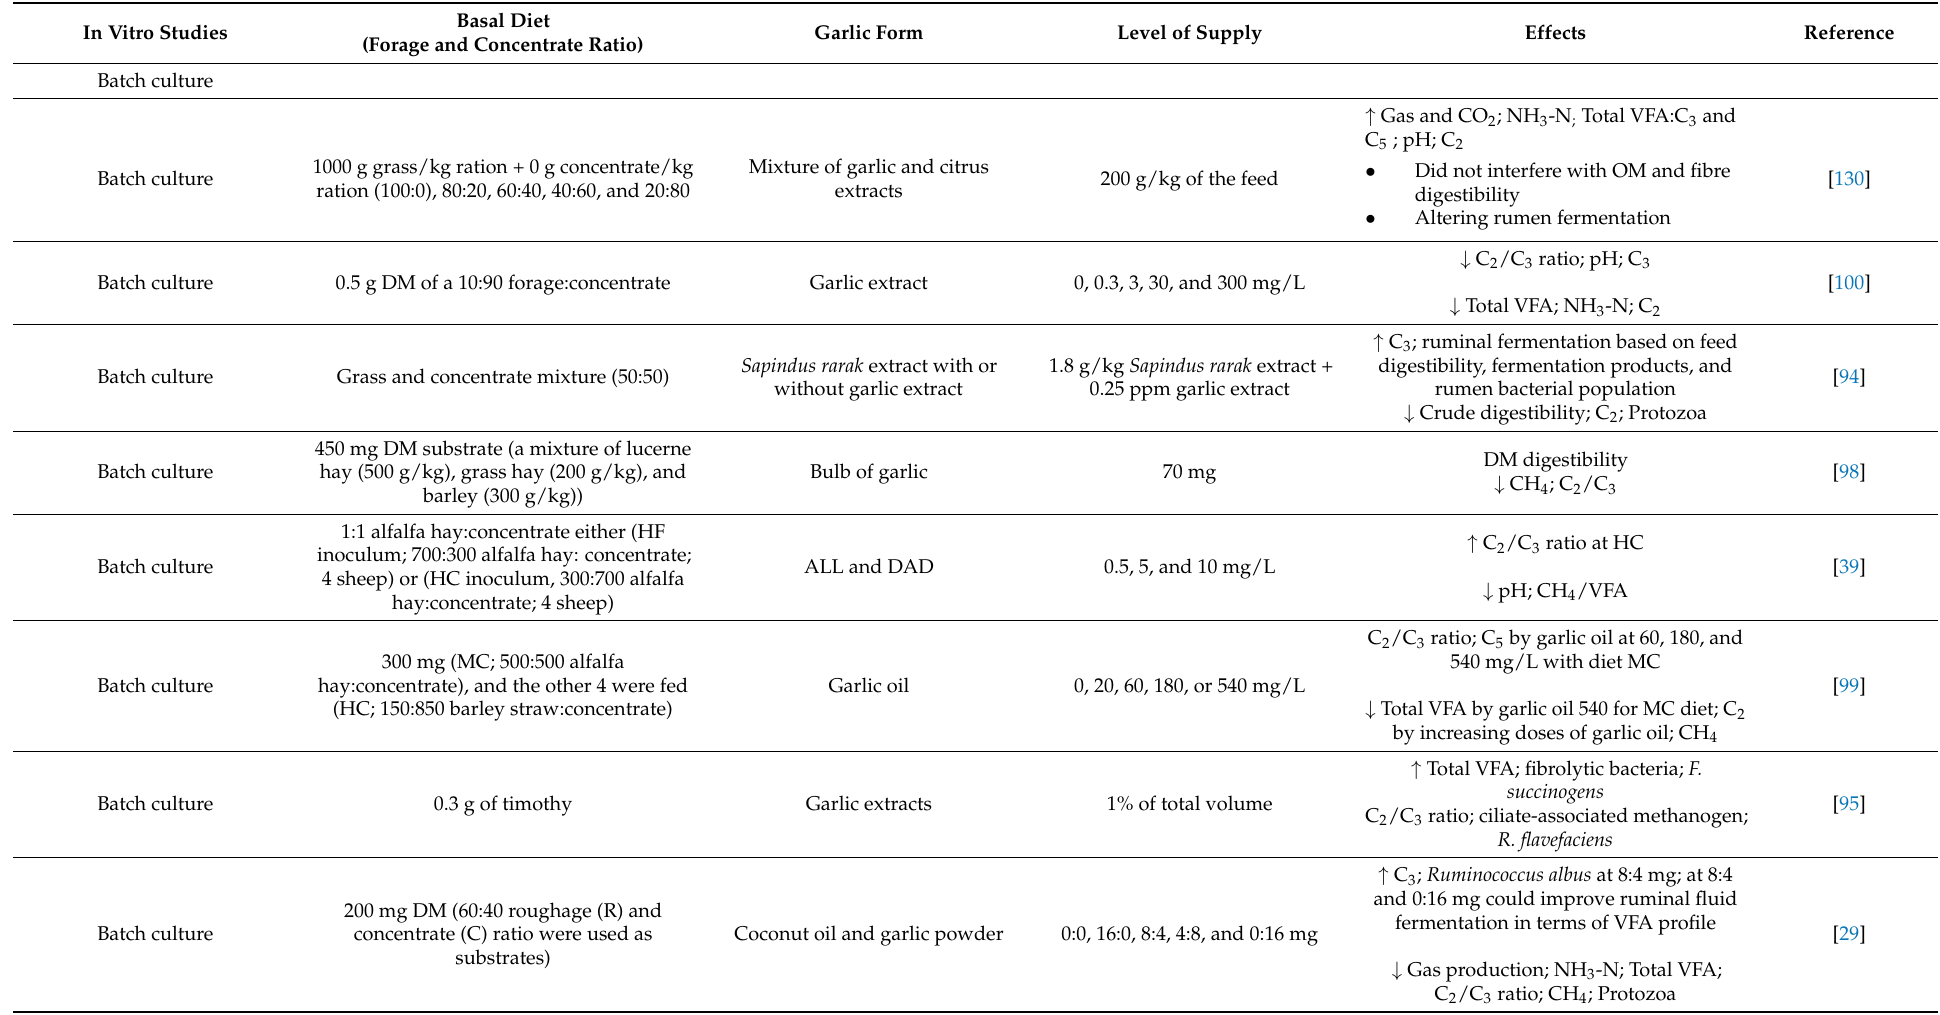
Table 4. In vitro trials that studied the effect of garlic on ruminant